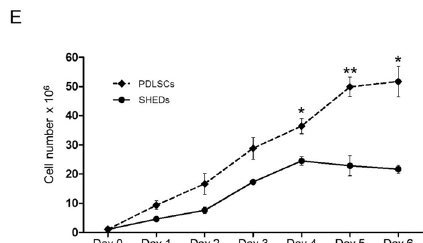
Figure 4. The PDLSC-specific-proteome contents catalogued via engagement of the nano-LC-MS/MS technology. ( A ) Categorization of the identified, via nano-LC-MS/MS advanced protocols, PDLSC- specific proteome into several protein classes, choosing as bioinformatics filter their contribution to